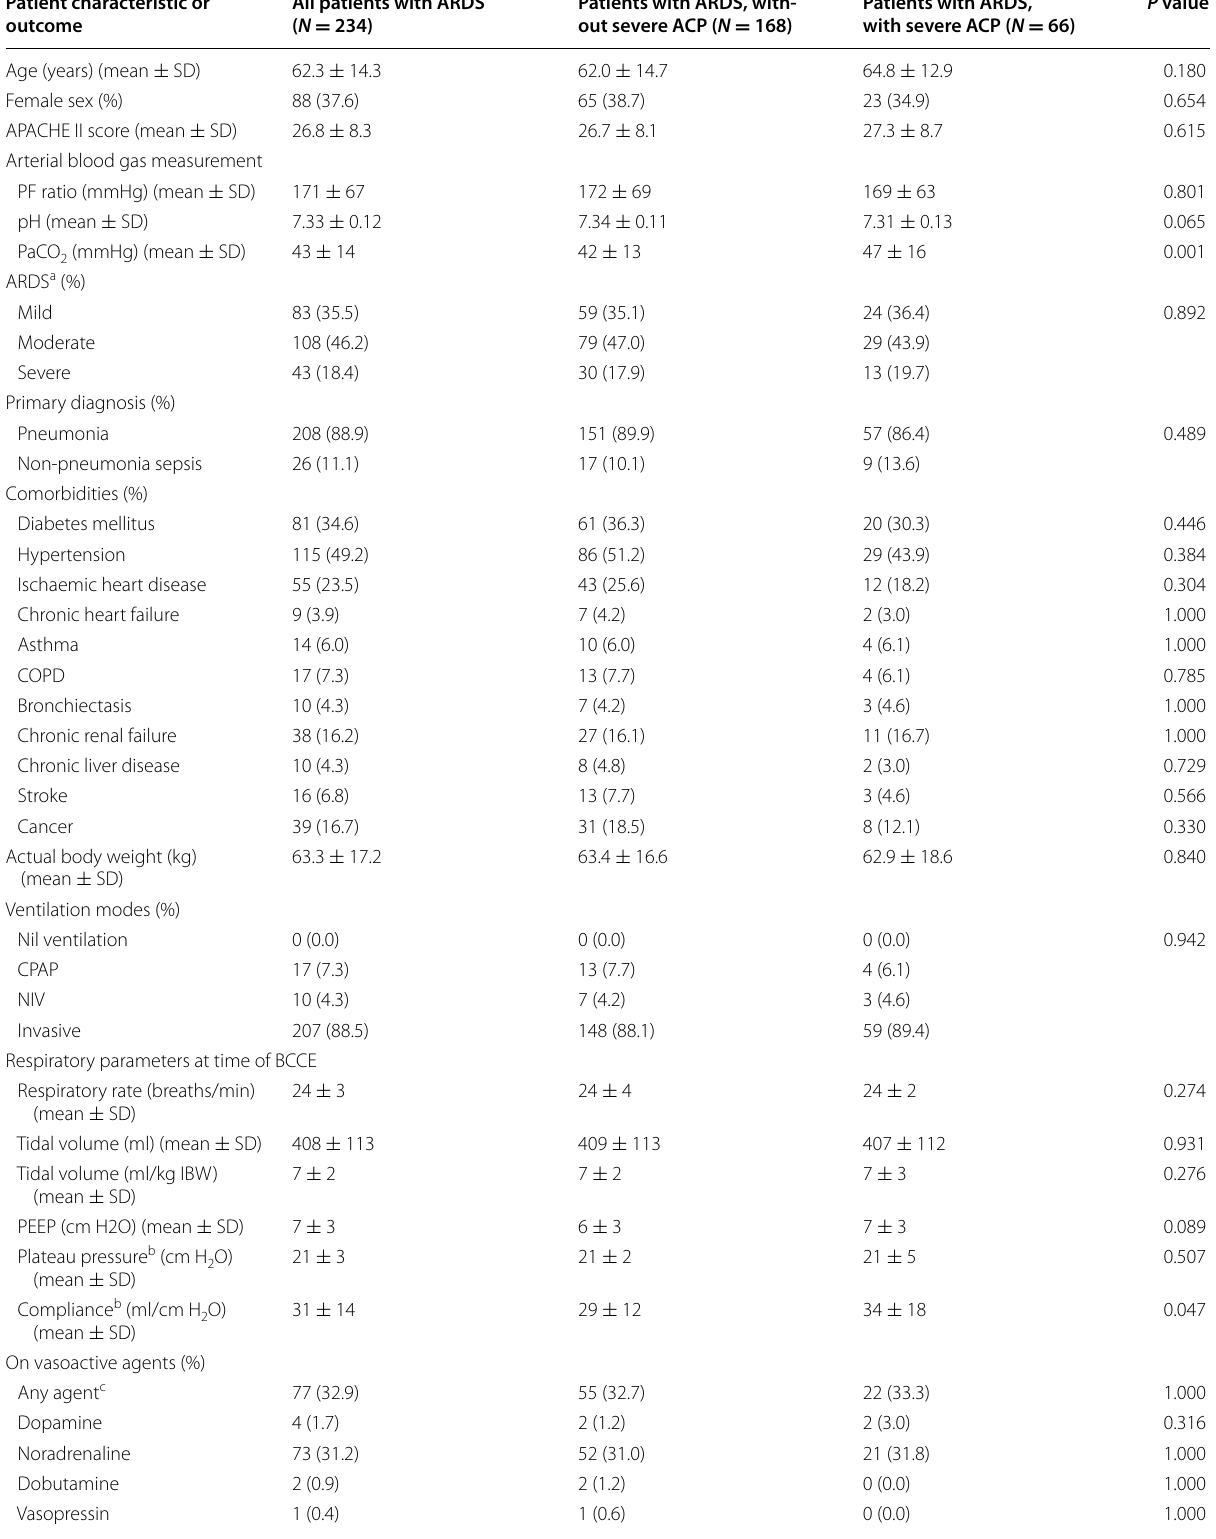
Table 1 Patient characteristics and